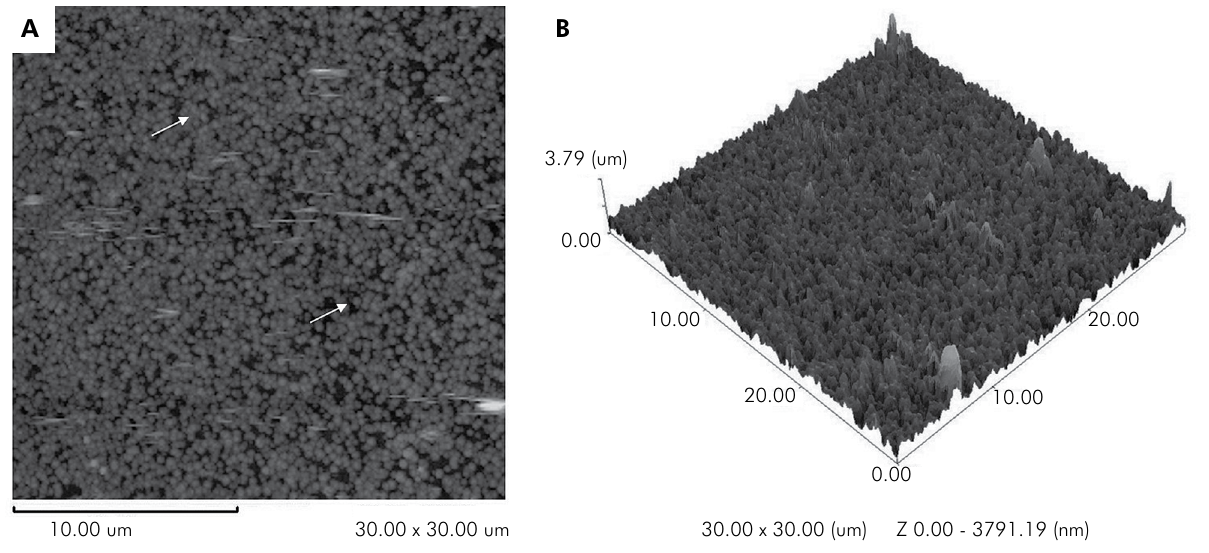
Figure 3. AFM image of enamel surface after TiF varnish application and erosive challenge. (A) ( → ) Continuous globular deposits 4 on surface. (B) Enamel surface completely covered by a layer of globular deposits.